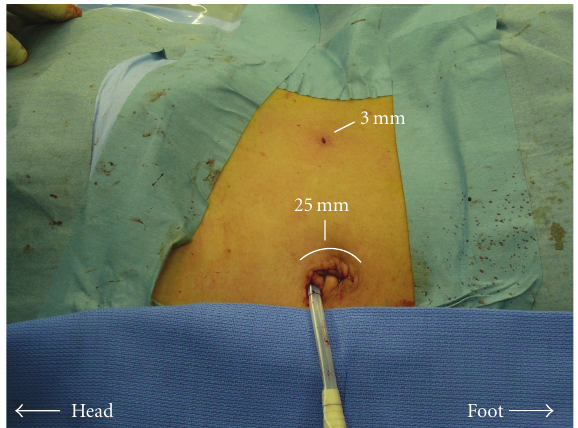
Figure 4: Postoperative appearance. A 6-mm tubular drain through the incision near the paraumbilicus was left in